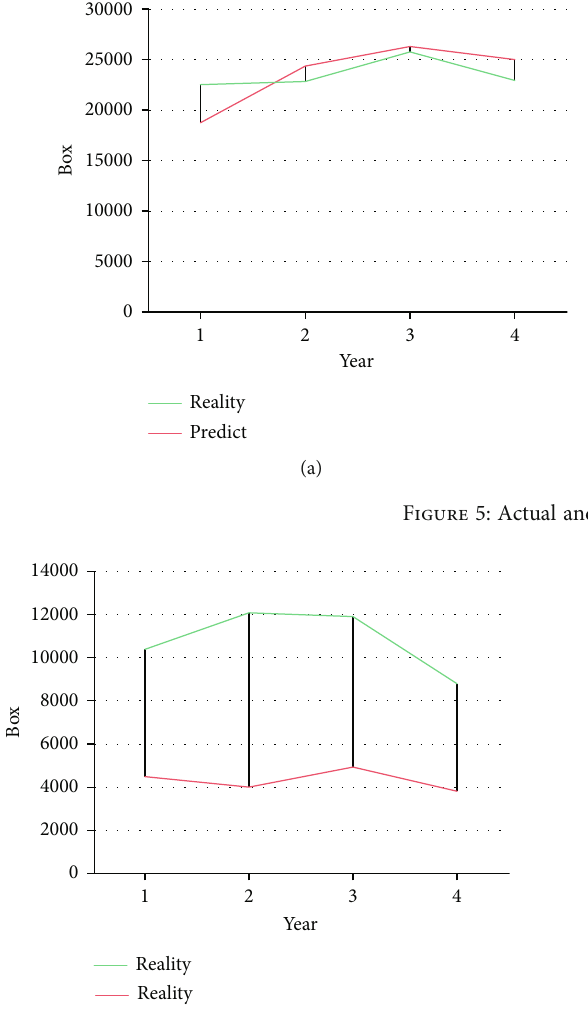
Figure 6: Expected results in the next two